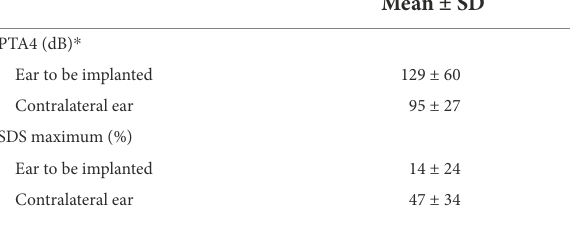
TABLE 2 Audiometric outcomes in both ears evaluated